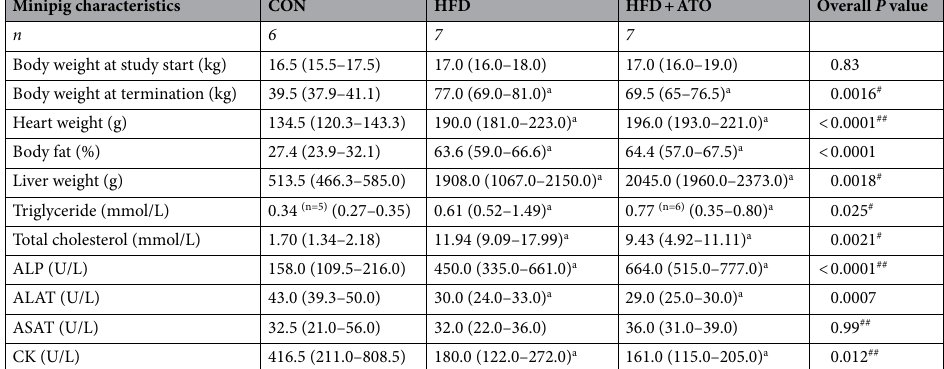
Table 1. Basic characteristics in the study population of Göttingen Minipigs. ALP alkaline phosphatase, ALT alanine-transaminase, ASAT aspartate transaminase, CK creatine kinase. Bodyfat (%) and triglyceride were determined 1–2 weeks prior to termination. Other parameters were determined at termination of the minipigs when not stated otherwise. Data are presented as median (interquartile range). a Different from CON, # Non-parametric test, ## Log transformation of data was performed before statistical analyses. There were no statistically significant differences between the HFD and HFD + ATO groups in background characteristics.